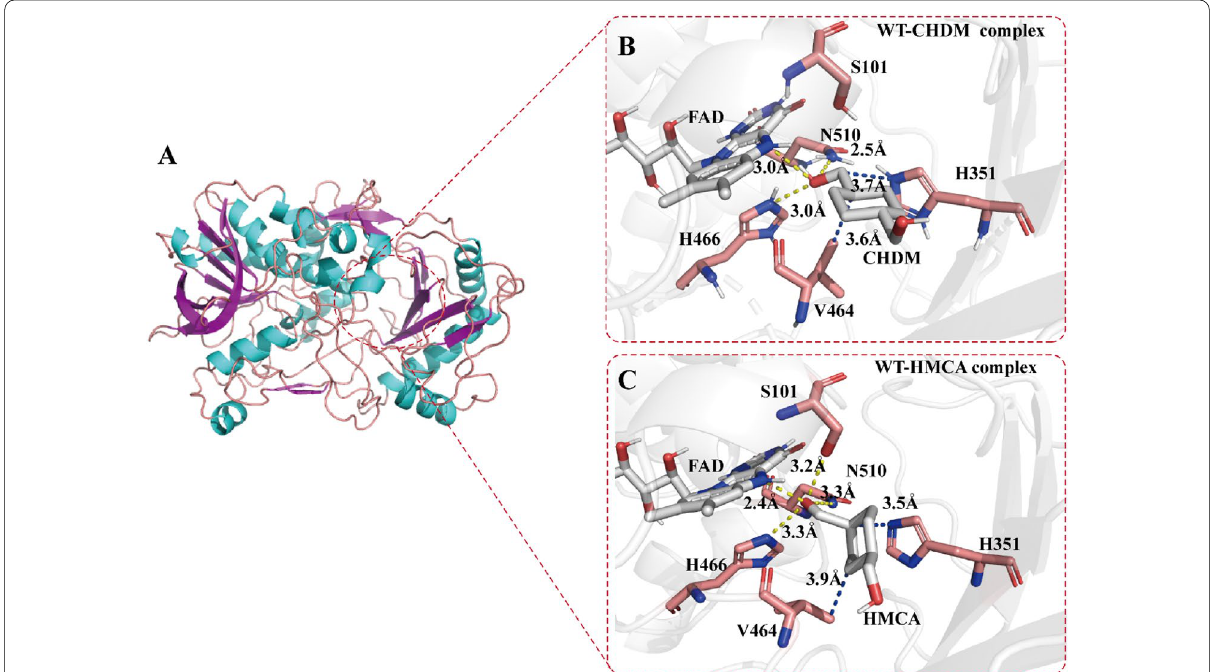
Fig. 2 Docking analysis of Ac CO (WT). A Homology model of Ac CO. B Docking model of CHDM in Ac CO. C Docking model of HMCA in Ac CO. CHDM, HMCA and FAD are shown in white, residues S101, N510, H466, V464 and H351 are shown in pink. The hydrogen-bond interactions are shown in yellow dash lines and steric interactions are shown in blue dash